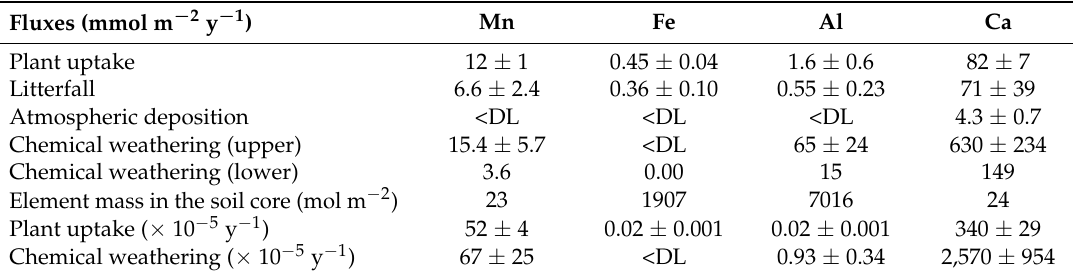
Table 4. Element fluxes ( ± standard error) through the plant–soil